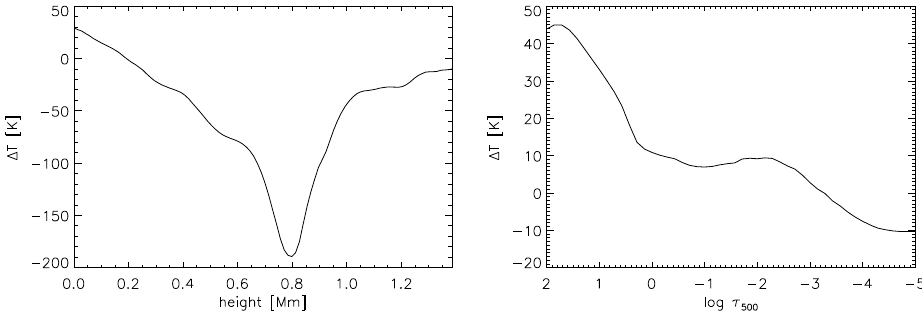
Figure 7. The difference between the mean temperature of the simulation runs with OPAL and VMW in the geometrical height scale (left) and in the continuum optical depth scale at 500nm (right). Note different scales in the two